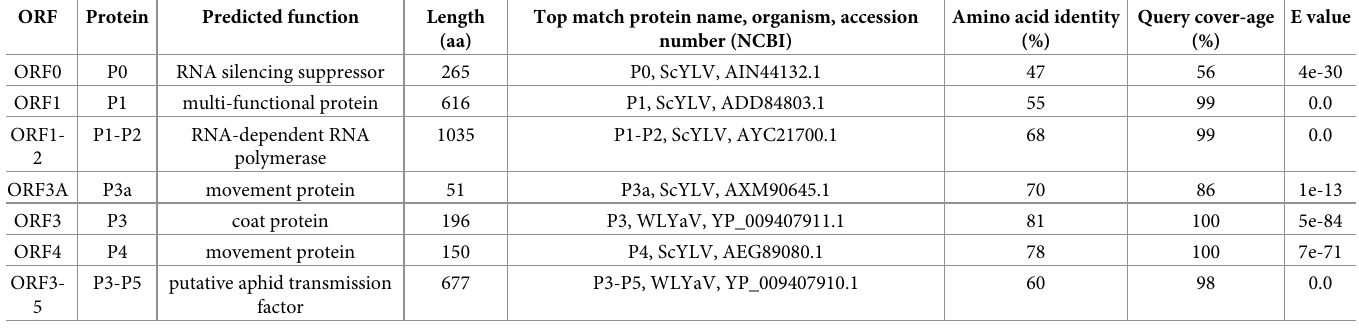
Table 2. Top match from amino acid sequence comparisons with predicted proteins from Miscanthus yellow fleck virus through blastp searches of the National Center for Biotechnology Information (NCBI) non-redundant protein sequence database.